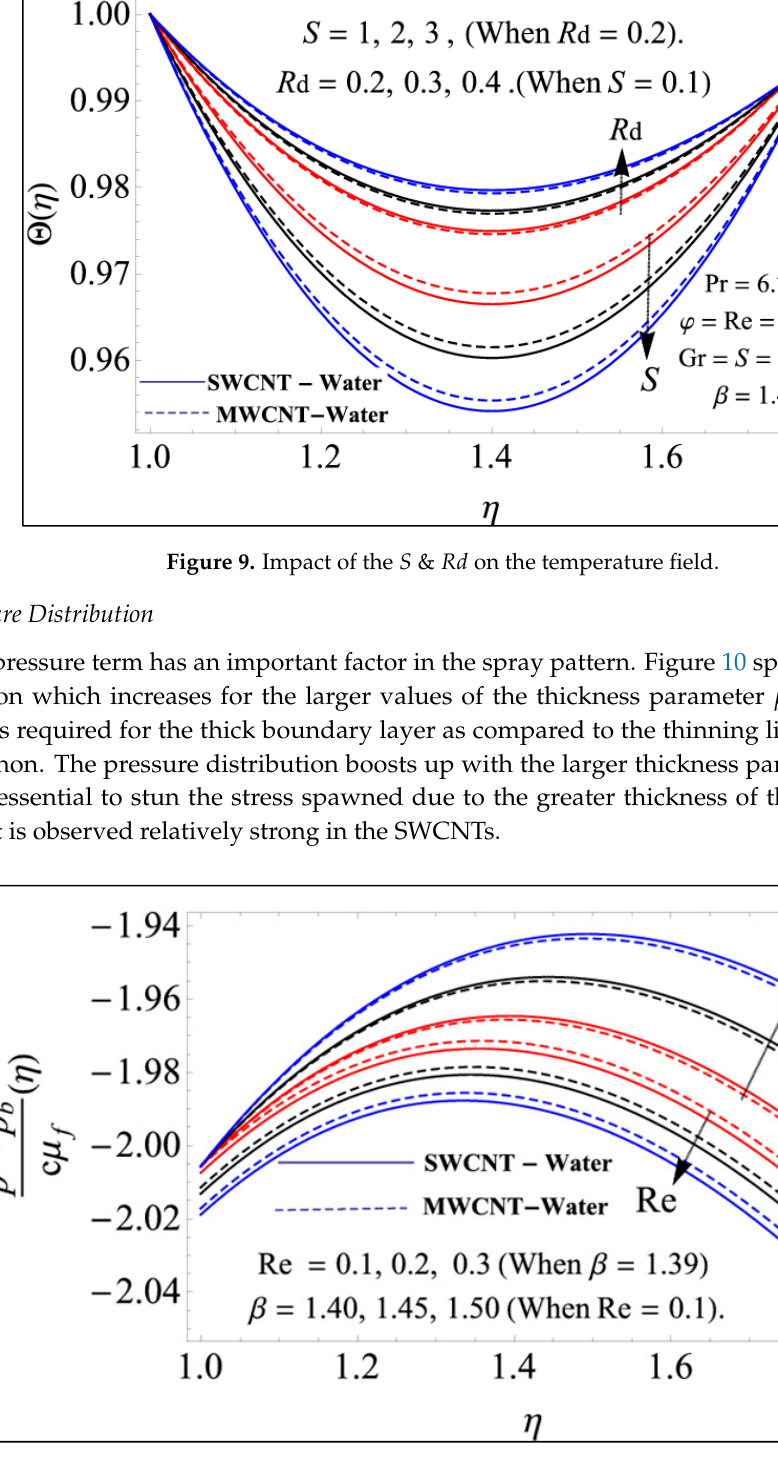
Figure 10. Impact of the Re & β on the pressure distribution.